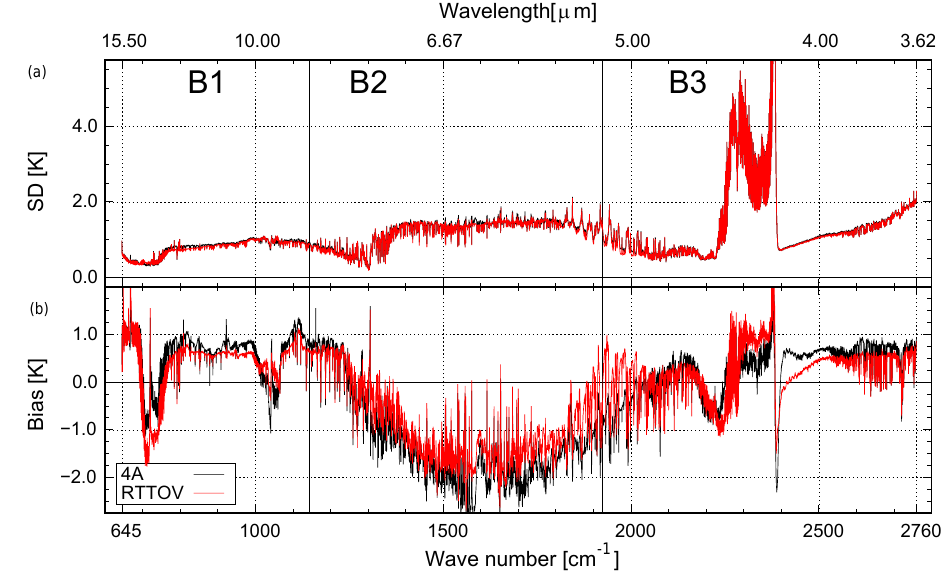
Figure 4. Statistics of IASI brightness temperature differences between model simulations (4A and RTTOV) and observations in terms of SD (a) and bias (b) . The observations were sampled during night-time over clear-sky ocean surfaces for a single orbit (6 August 2013). The sample size is 2877. B1, B2 and B3 correspond to the three IASI bands.